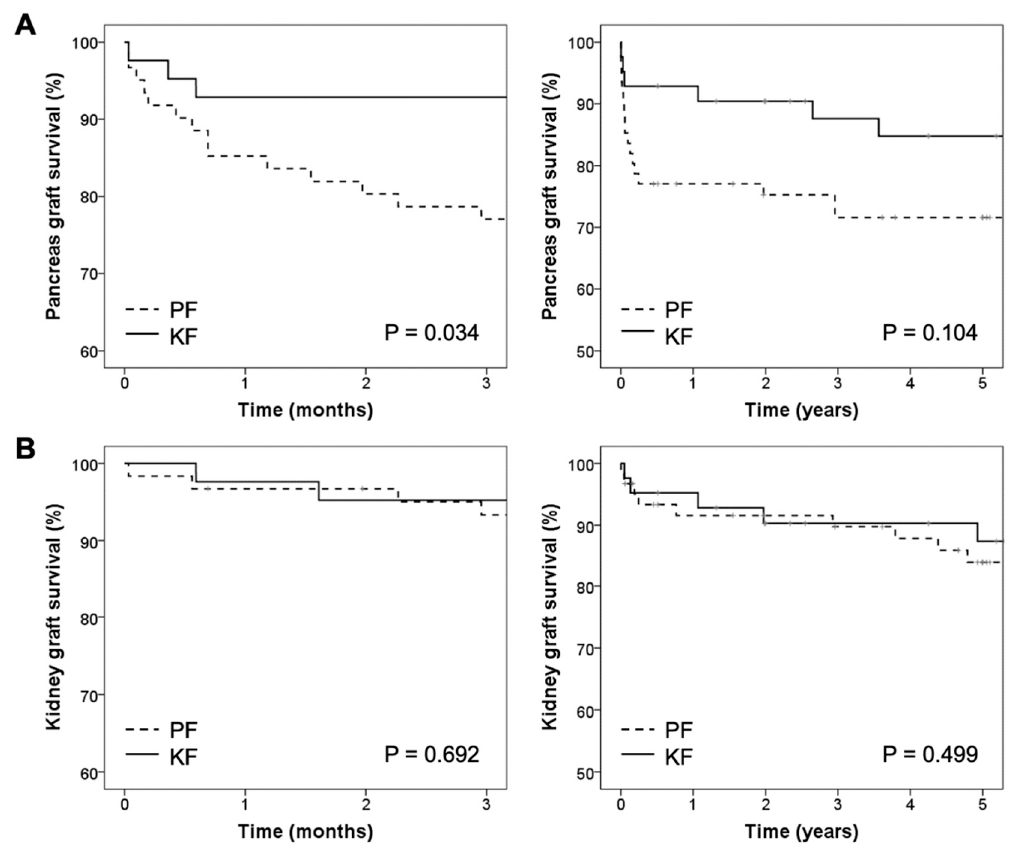
Figure 1. Graft and patient survival according to the graft implantation order. ( A ) pancreas graft survival, and ( B ) kidney graft survival three months and five years after simultaneous pancreas-kidney transplantation.